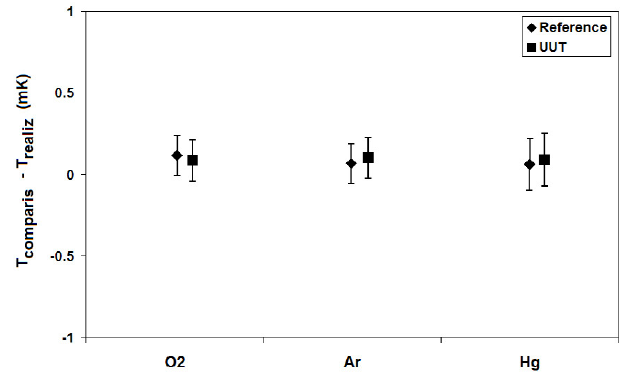
Fig. 4. Temperature difference between calibrate values by comparision and those calibrated by realization of O 2 TP, ArTP and HgTP.